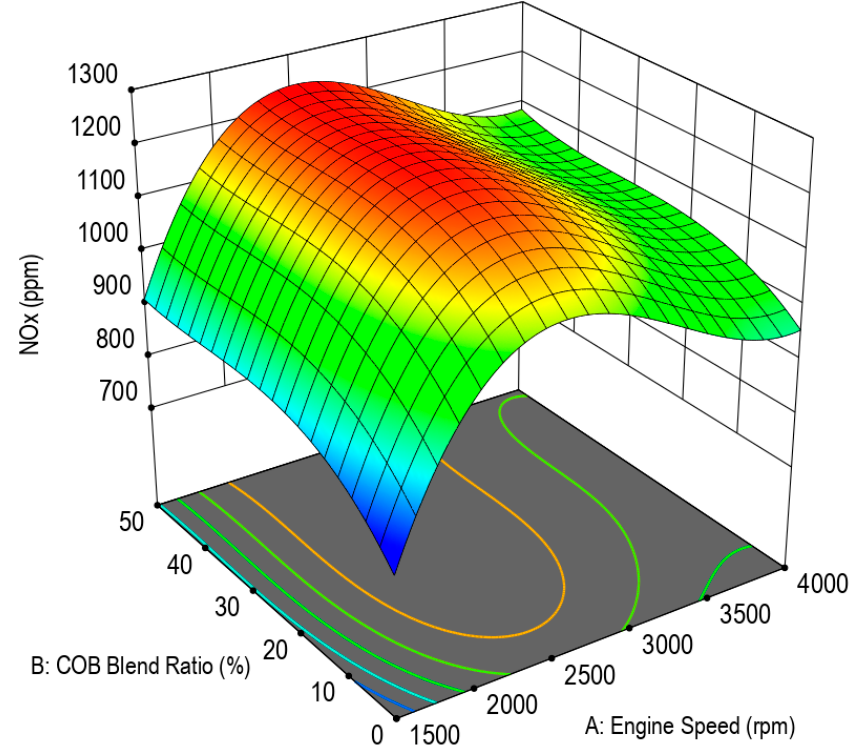
Figure 7. NOx emissions versus engine speed for all test fuels.